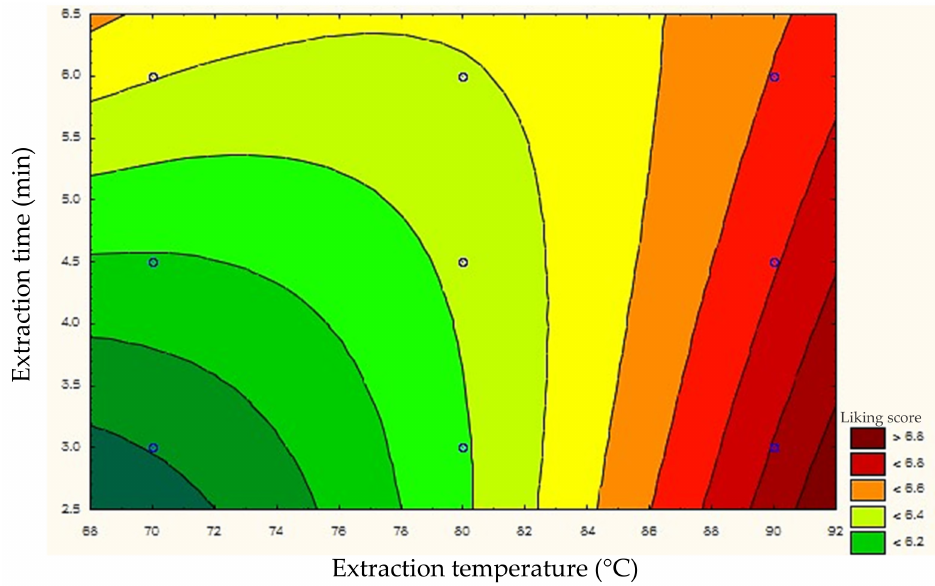
Figure 3. Contour plot for flavor liking score as a function of extraction temperature and time.